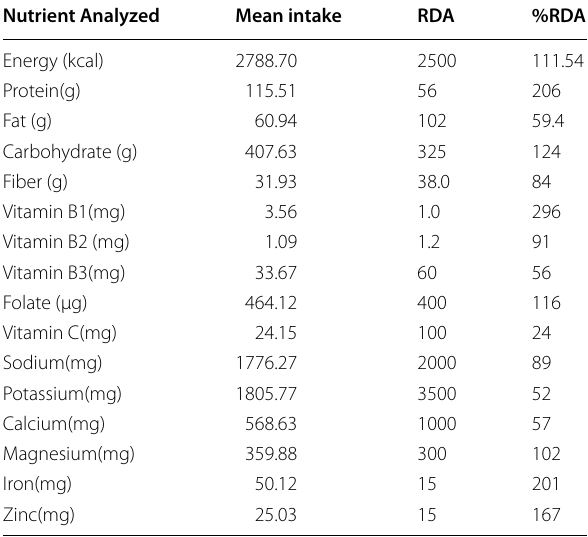
Table 4 Mean energy and nutrient intake of the